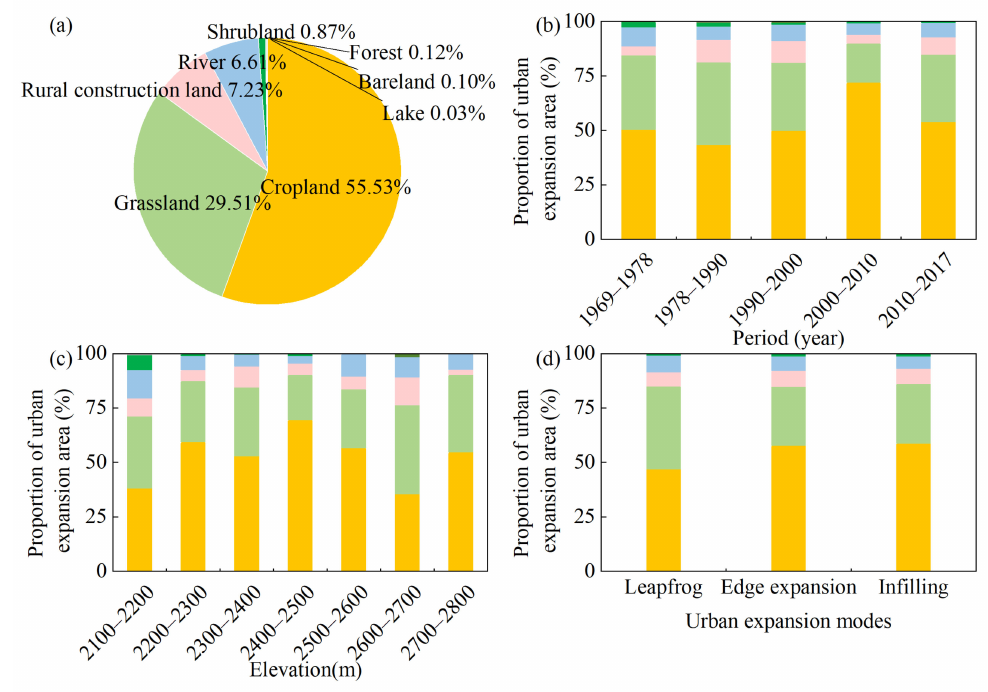
Figure 7. Different land use/cover types occupied during the urban expansion of Xining City. ( a ) in the entire region from 1969 to 2017; ( b ) in the entire region in different periods; ( c ) at different altitudes from 1969 to 2017; ( d ) under different urban expansion modes from 1969 to